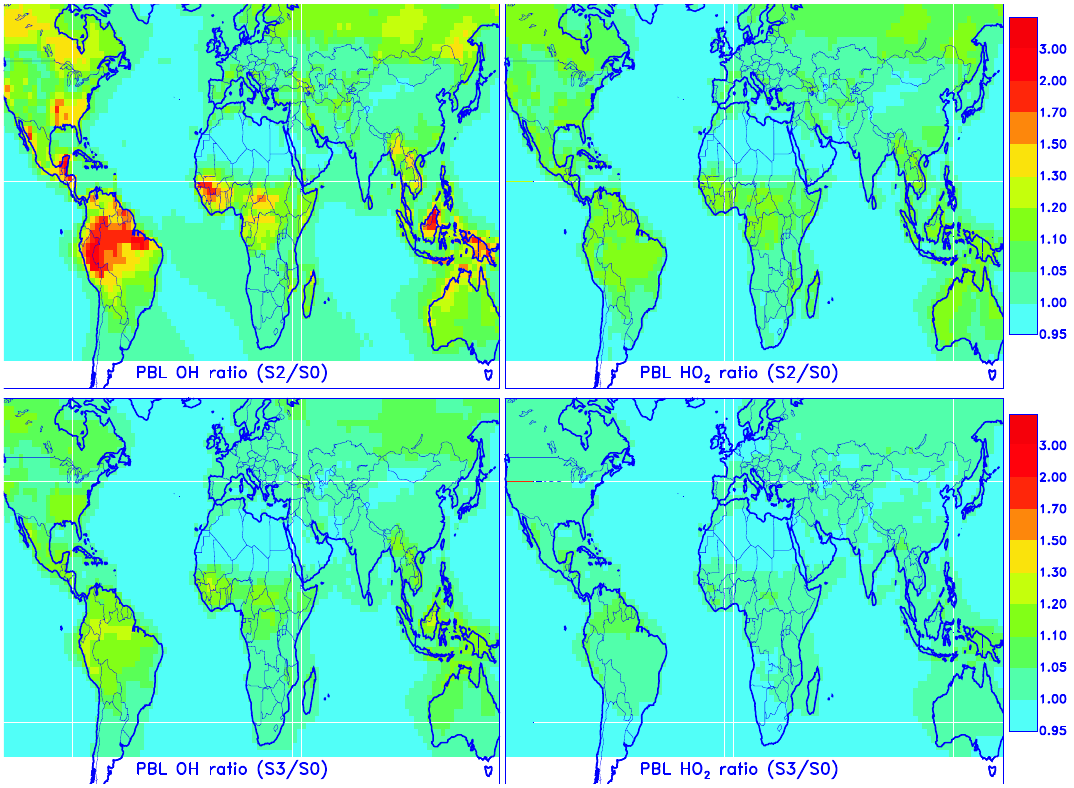
Fig. 3. Calculated impact on OH (left) and HO 2 (right) concentrations (July 2005, below 1.5km) of (1) the artificial addition of 2 OH radicals formed in the reaction of isoprene peroxy radicals with HO 2 (upper panels), and (2) the epoxide formation and oxidation mechanism (lower